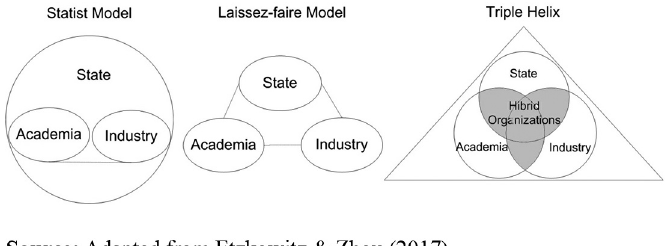
Figure 1. Representation of the stages of development of